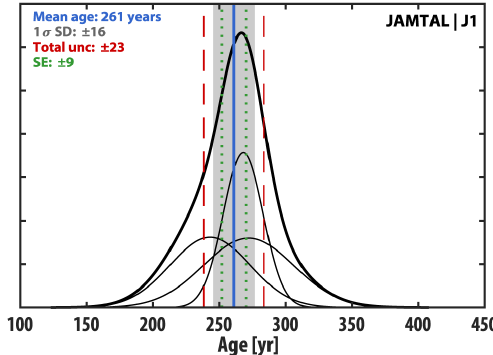
Figure 6. Kernel plot of LIA ages produced from boulders embed- ded in the historical moraine at Jamtal. The gray-shaded bar illus- trates the 1 σ standard deviation (SD) of the landform age calcu- lated from analytical uncertainties of individual samples. Dashed red lines add the production rate uncertainty and the uncertainty of the carrier concentration to the 1 σ SD and indicate the total un- certainty. Dotted green lines show the standard error (SE), which describes the dispersion of different sample means from the popu- lation